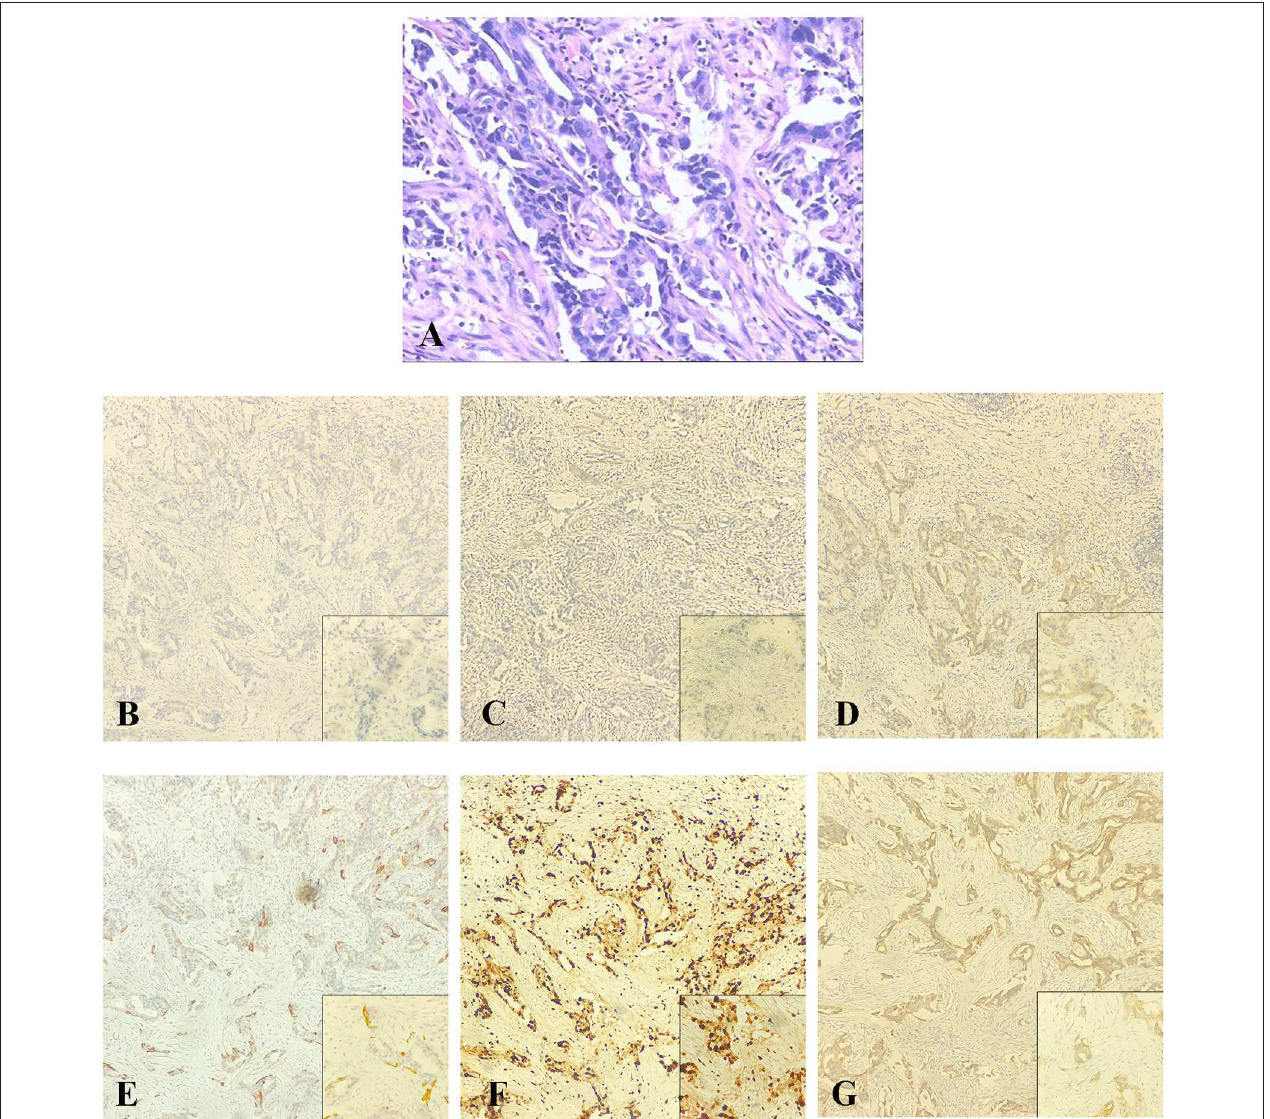
FIGURE 2 | The postoperative pathological examination with hematoxylin and eosin (HE) staining and immunohistochemical (IHC) staining of the primary tumor in 2015. (A) Histological findings with HE staining at high magnification (40 × ) showed that the tumor was an invasive ductal carcinoma. (B–G) IHC staining was used to detect the expressions of ER, PR, HER-2, CK5/6, Ki-67, and EGFR at original magnification (10 × ). (B) ER negative. (C) PR negative. (D) HER-2 weakly positive. (E) CK5/6 negative. (F) Ki-67 positive (80%). (G) EGFR focal positive.